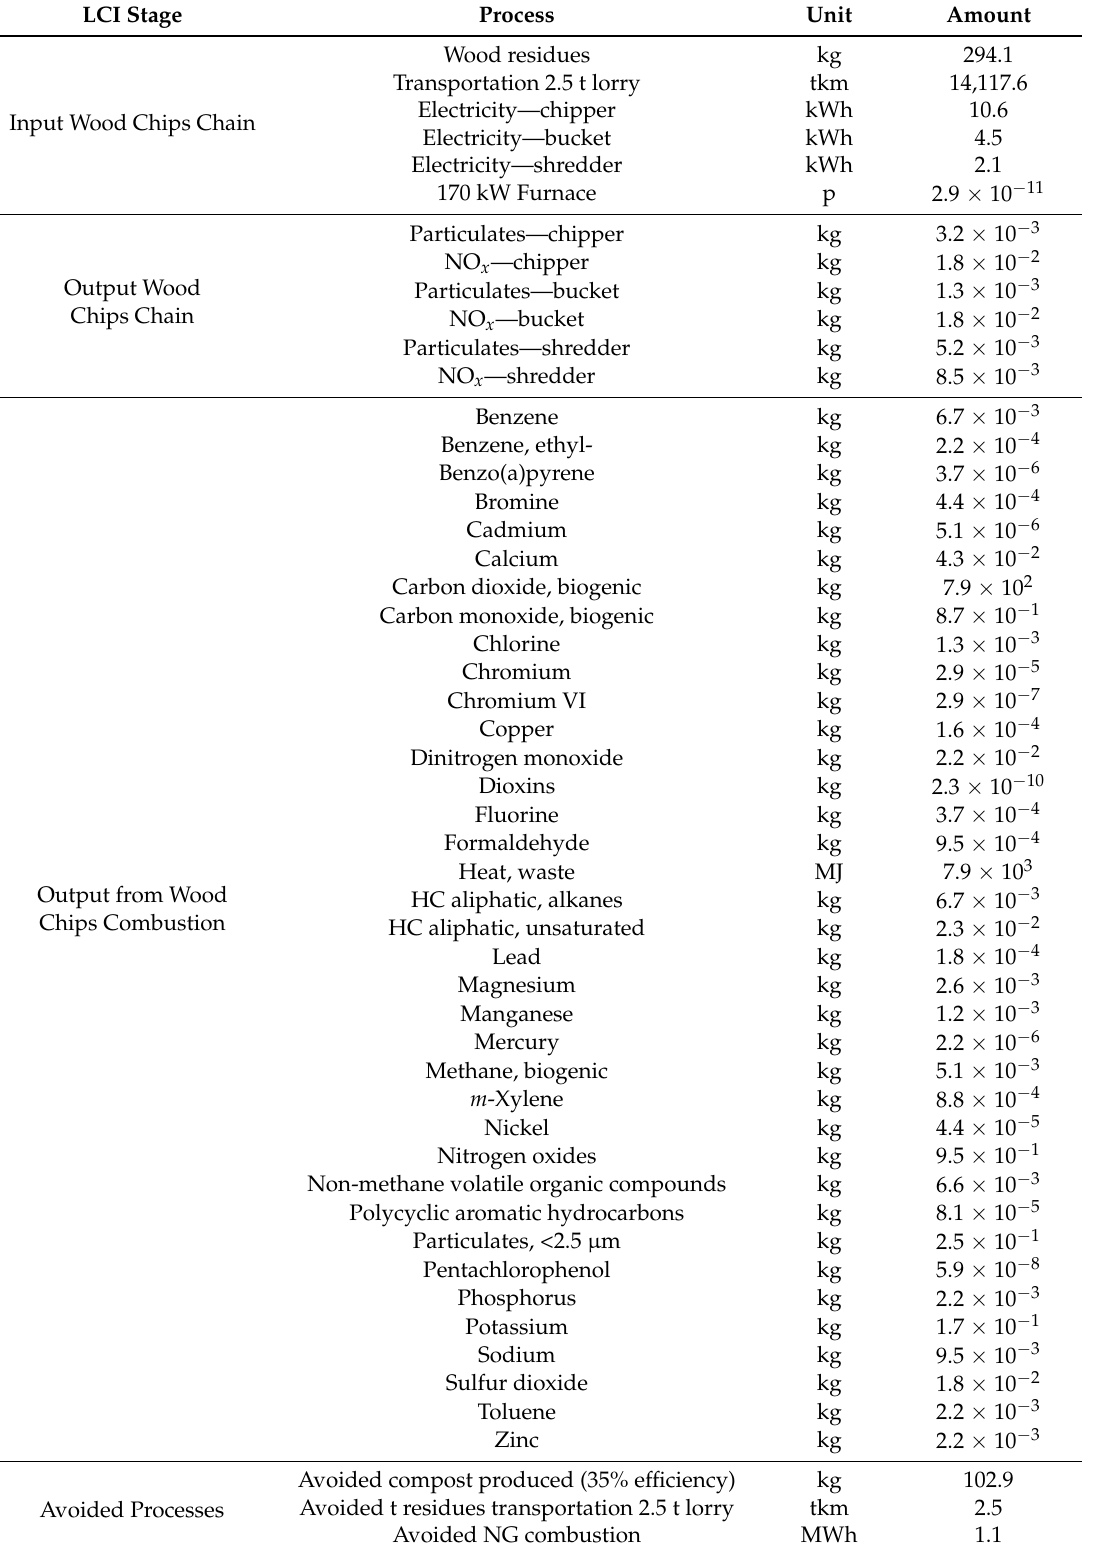
Table 3. LCI for the wood-residues